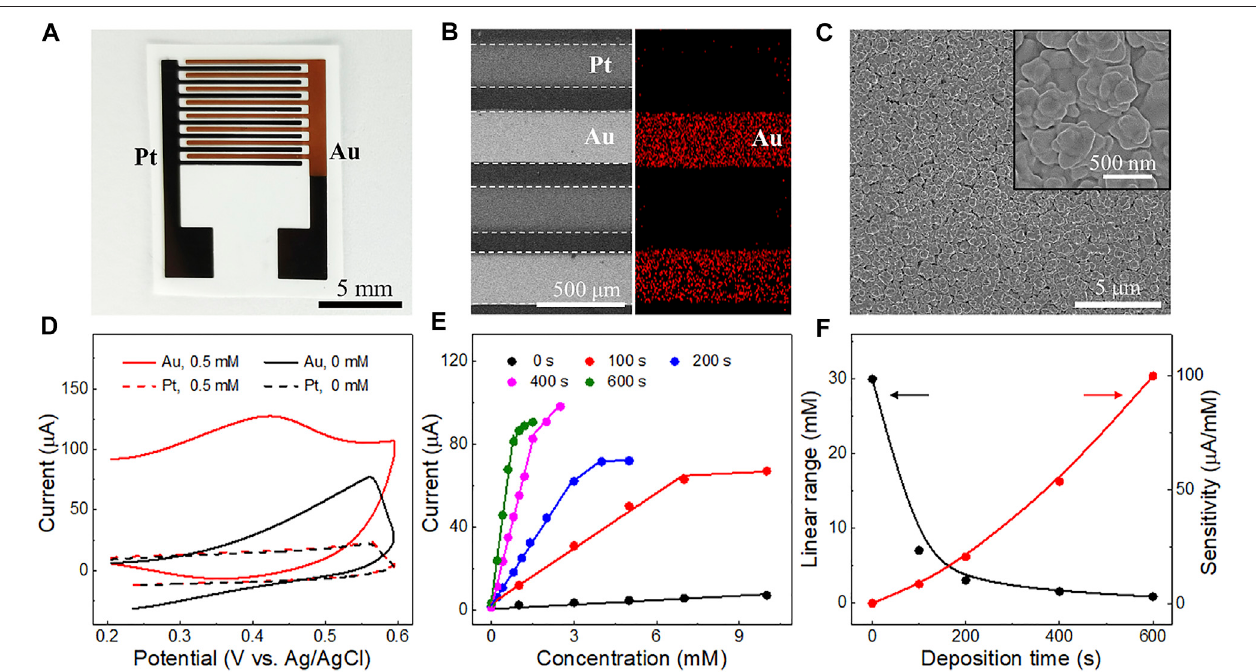
FIGURE4 |(A) Photograph ofthetriphase electrodes after 400 s Auelectrocatalyst deposition on thePt detection electrode. (B) SEMimage ofthetriphase Pt-Au electrodes(left)andthecorrespondingAuelementalmappingdistribution(right). (C) SEMimagesoftheAunanoparticleswithdiameterrangingfrom200to500 nm.The inset is an enlarged SEM view of the Au nanoparticles. (D) Cyclic voltammetry curves of the Pt-Pt and Pt-Au electrodes obtained in solutions with or without glucose (0.5 mM). (E) CorrespondingcalibrationplotsoftheelectrodeswithdifferentAuelectrodepositiontimes(100,200,400and600 s)derivedfromtheiramperometric i-t curves ( Supplementary Figure S7 ) at 6 s. (F) Relationship between the linear detection range (black curve) and the sensitivity (red curve) of electrodes with different Au electrodeposition